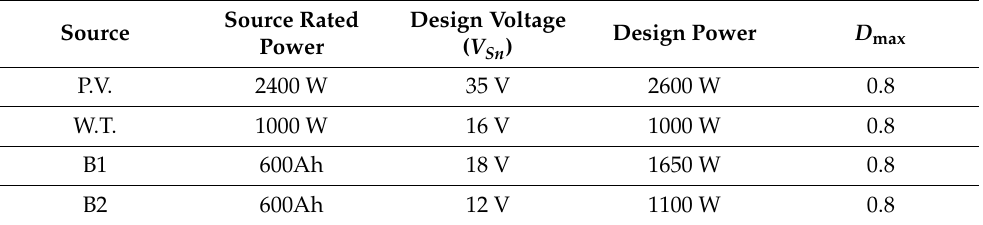
Table 1. Design data for the step-up mode of the Uc and Bc converters.